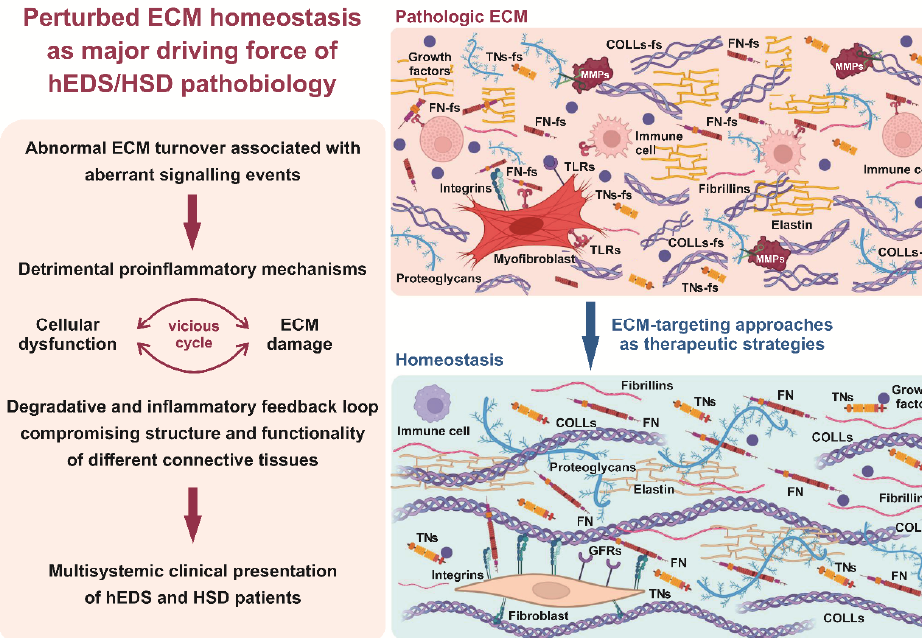
Figure 6. Proposed hEDS/HSD disease model. Schematic representation summarizing the main biological knowledge on molecular mechanisms involved in the hEDS/HSD pathophysiology emerging from the present and our previously published findings [19,22,23]. Abnormal ECM turnover and overproduction of ECM-generated DAMPs act as main triggers in the disease process, sustaining an uncontrolled degradative and proinflammatory vicious cycle affecting homeostasis and integrity of a range of connective tissues, finally leading to the complex clinical manifestation of hEDS/HSD patients. The identification of ECM-related disease drivers may offer ECM-targeting approaches as therapeutic strategies (e.g., doxycycline-mediated MMP inhibition). Abbreviations: COLLs-fs: fragments of collagens; FN-fs: fragments of fibronectin; GFRs: growth factor receptors; MMPs: